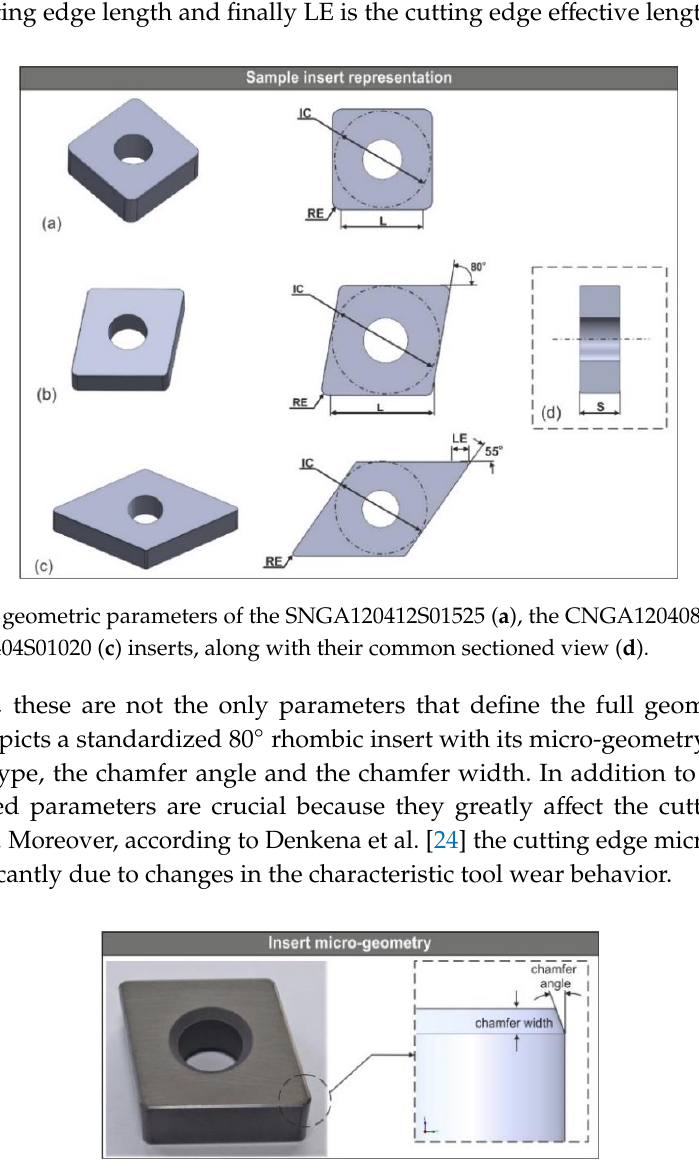
◦ diamond-shaped Figure 2. The micro-geometry of a typical 80° diamond-shaped insert. Figure 2. The micro-geometry of a typical 80 Figure 2. The micro-geometry of a typical 80° diamond-shaped insert.